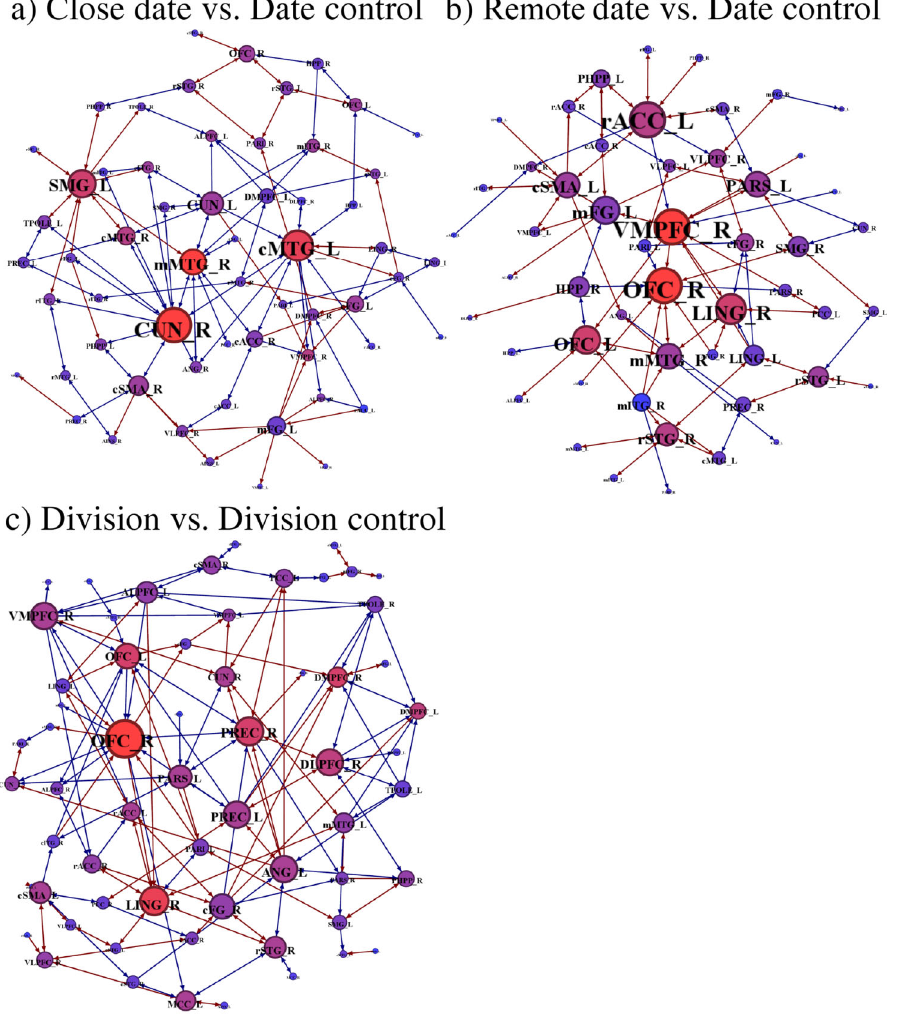
Figure 4. Effective connectivity for close, remote dates and division with the respective control conditions (a, b and c). Node diameter represents degree (total number of connections), whereas node colour (blue through red) encodes indegree (number of significant entrant connections). CUN: cuneus, MTG: middle temporal gyrus, SMG: supramarginal gyrus, OFC: orbitofrontal cortex, VMPFC: ventromedial prefrontal cortex, rACC: anterior cingulate cortex, LING: lingual gyrus, PARS: superior parietal lobule, PREC: precuneus. See Table 1 for full list of